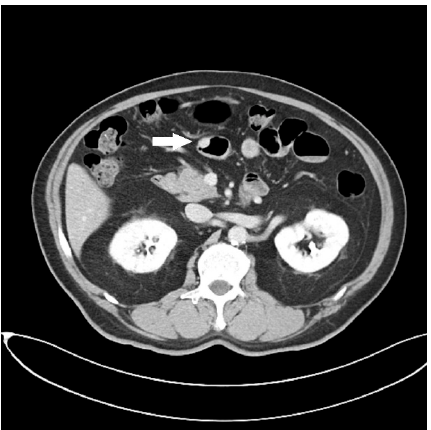
Figure 1. Abdominal CT finding of a small enhanced nodule in the jejunum